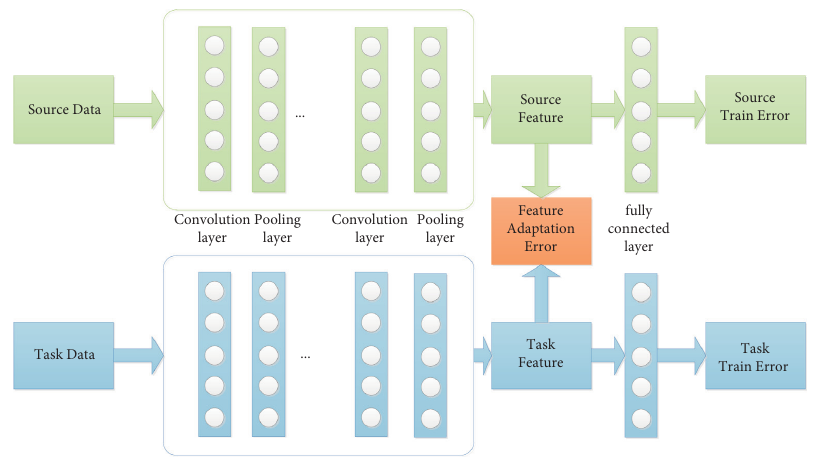
Figure 4: The network structure of the proposed